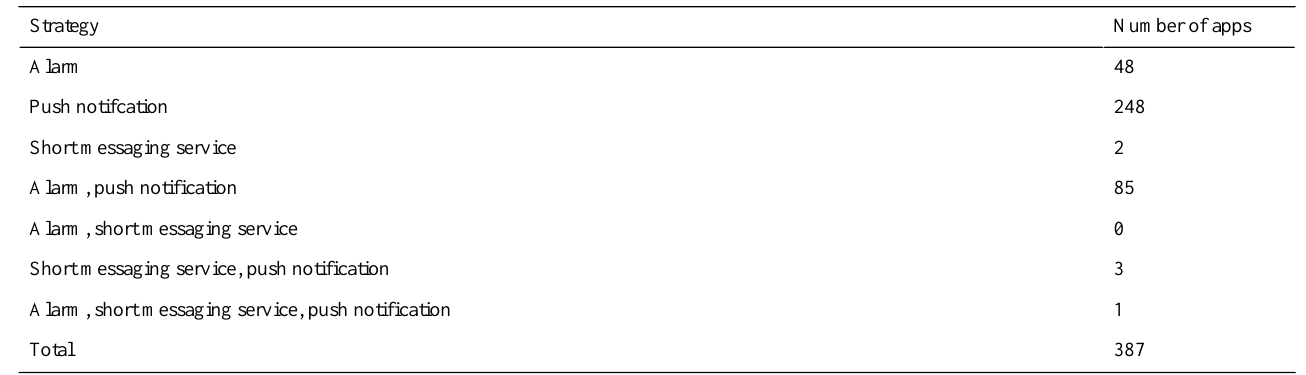
Table 2. Number of apps adopting reminder